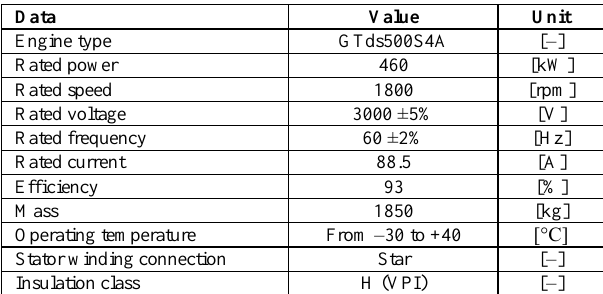
Table 2. Technical specifications of the GTds500S4A generator